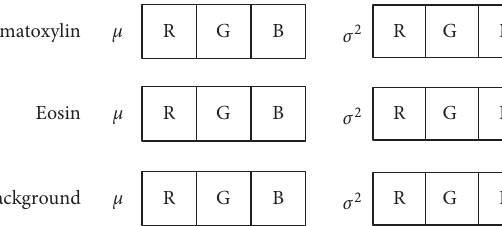
Figure 4: Stain mean and variance of the color